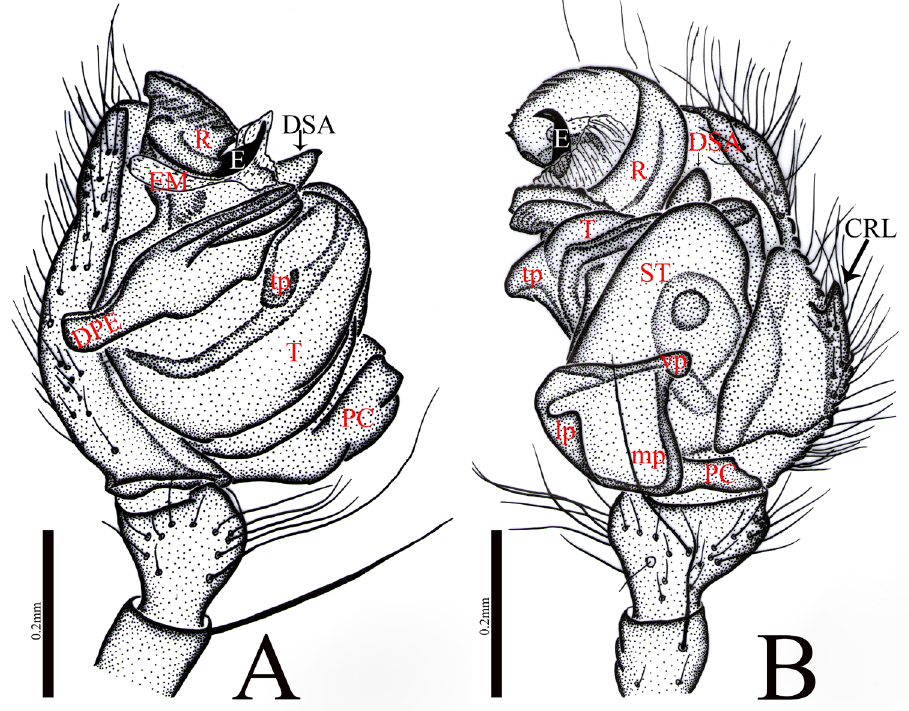
Fig. 3. Acroterius absentus gen. et sp. nov., ♂, holotype (HNU-Tang031027), palp. A . Prolateral view. B . Retrolateral